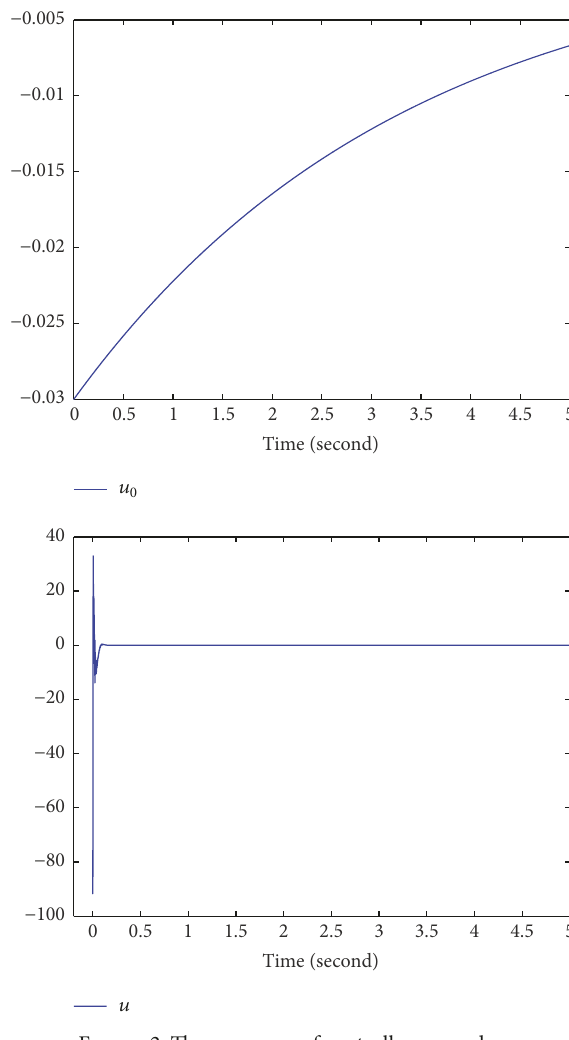
Figure 2: The responses of controllers 𝑢 0 and 𝑢 .